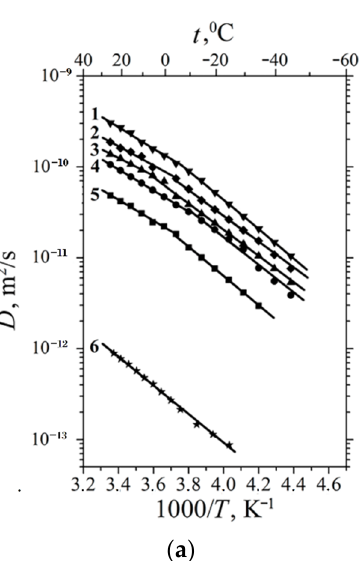
Figure 28. ( a ) Temperature dependences of the average H + and water-self diffusion coefficients for the Nafion 117 membrane with different water contents: λ is 12 (1); λ is 7.4 (2); λ is 6.4 (3); λ is 5.8 (4); λ is 4.4 (5); and λ is 3.2 (6); ( b ) water self-diffusion activation energies in the high-temperature range (squares—curve 1) and low temperature range (circles—curve 2). Reprinted with permission from Ref. [41]. Copyright © 2022 Springer-Verlag GmbH Austria, part of Springer Nature.